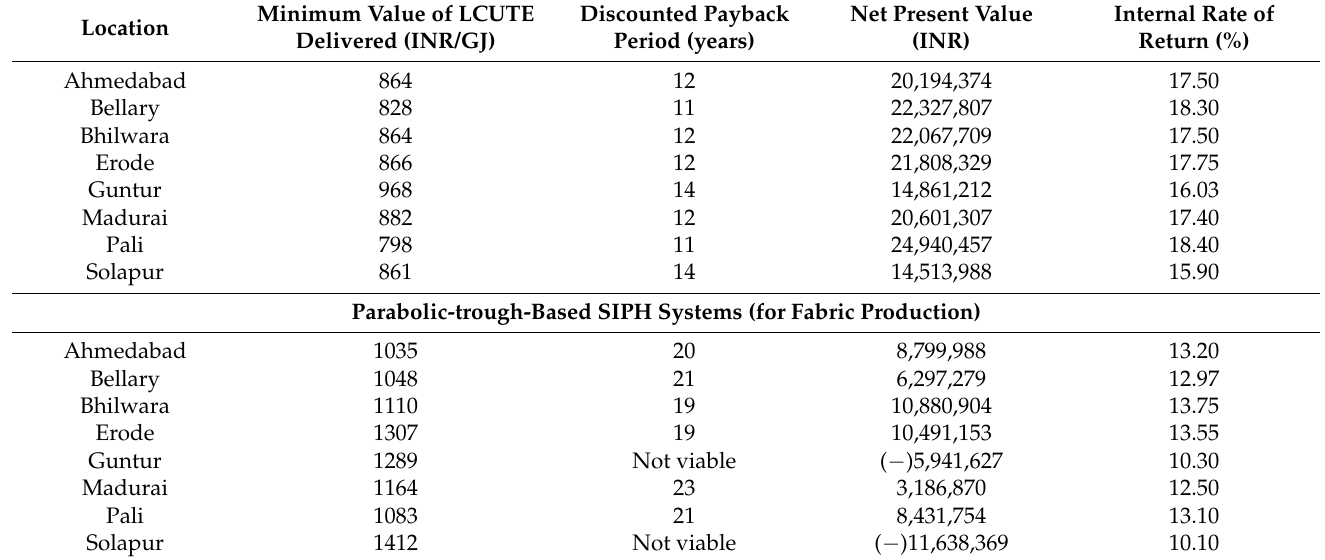
Table 7. Measures of financial viability of SIPH systems in the textile industry in India (for cotton- based yarn and fabric